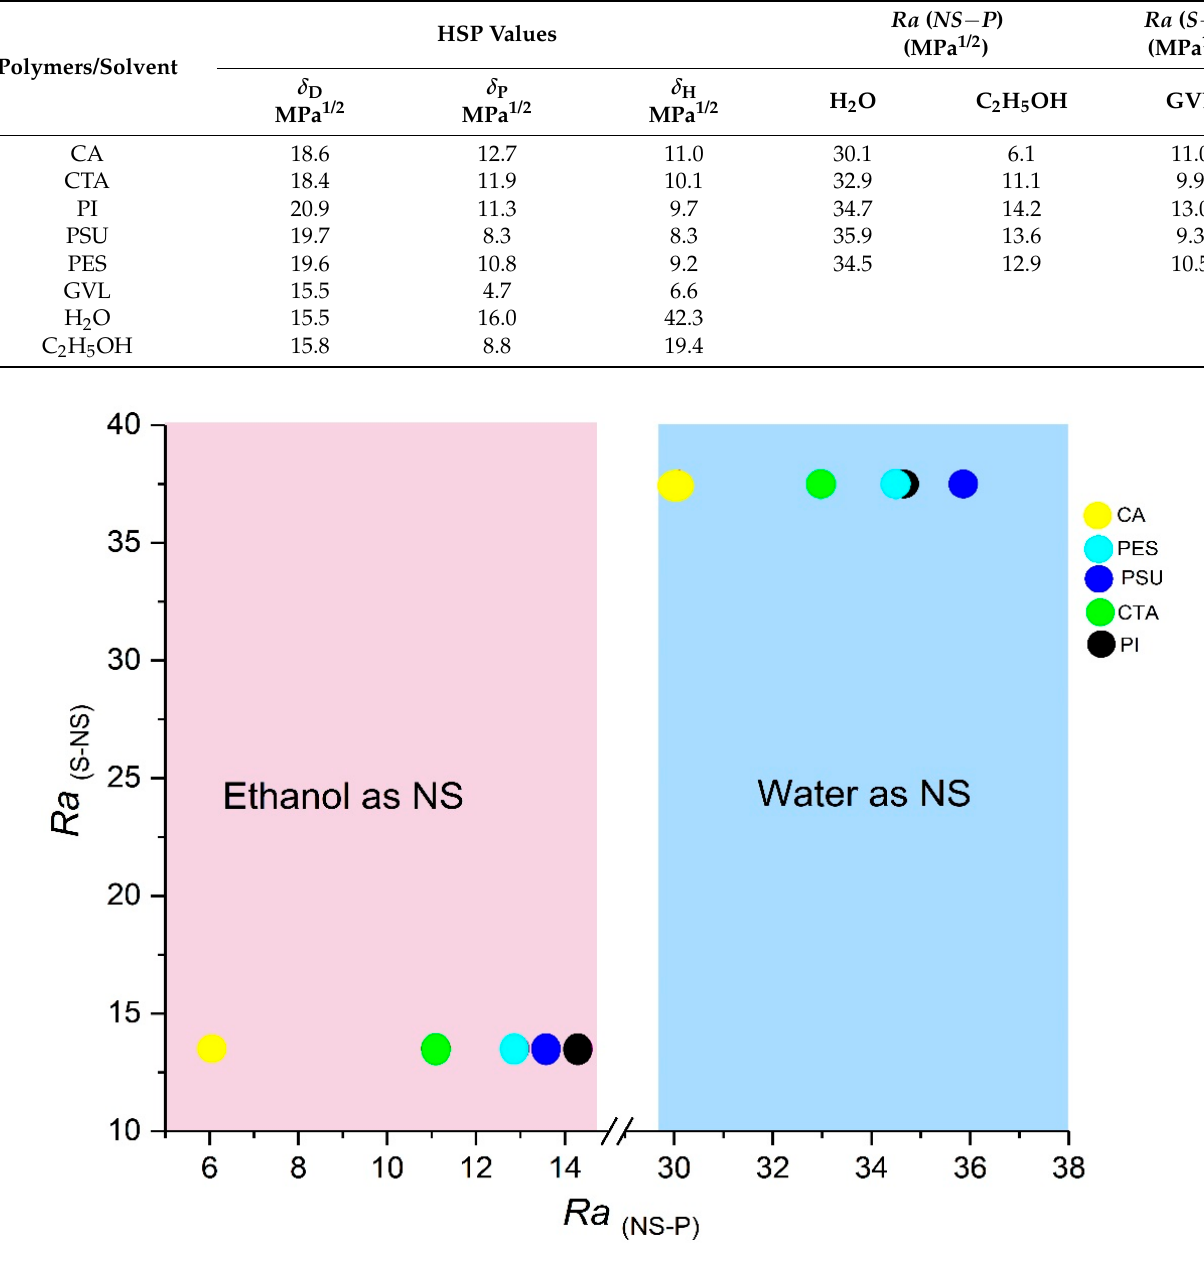
Figure 1. Interaction distance between solvent and non-solvent ( Ra S − NS ) vs. the interaction distance between non-solvent and polymer interaction ( Ra NS − P )